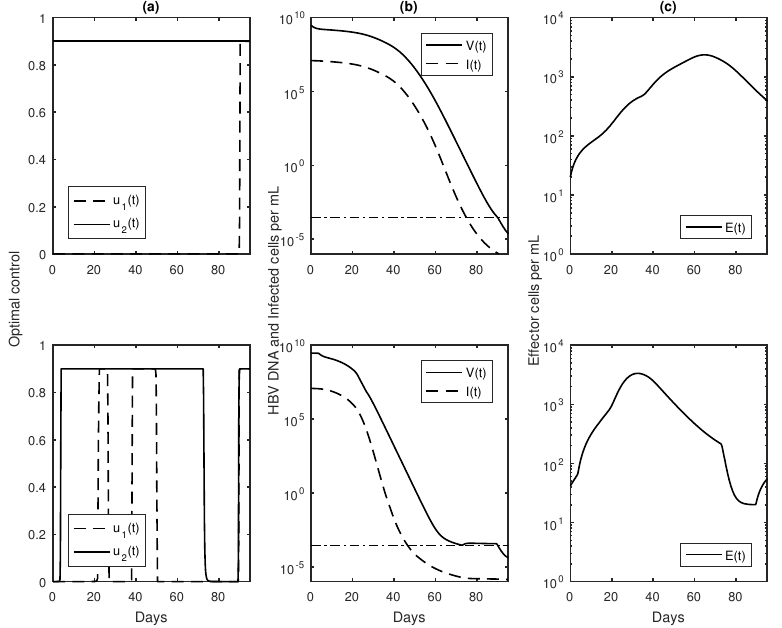
Figure 7. ( a ) Optimal evolution for controls u 1 (dashed lines) and u 2 (solid lines) as given by (15); ( b ) virus V per mL (solid lines) and infected cells I per mL (dashed lines) over time; ( c ) effector cells E per mL over time when drugs are introduced at peak virus concentration for: a 1 = a 2 = a 3 = b 1 = b 2 = 1, f = 0.5 and τ = 33.4 (top row); τ = 15.2 (bottom